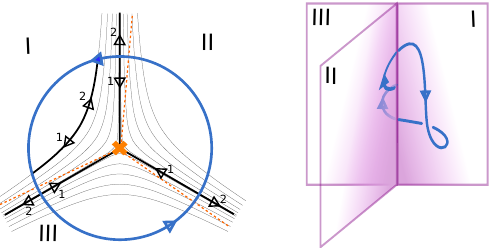
Figure 24 . An unknot K encircling one strand of the branch locus of the covering f M ! M . Left: the projection of K to C . The height coordinate of K is taken as follows: as we travel counterclockwise around K the height monotonically increases, except for a small neighborhood of the (cid:12)lled arrow on K , where the height decreases. The projections of generic leaves of the WKB foliation are shown in light gray. The projections of special leaves, along which a detour or exchange may occur, are shown in black. Right: the projection of K to the leaf space of the foliation. The vertical direction in the leaf space corresponds to the height direction.